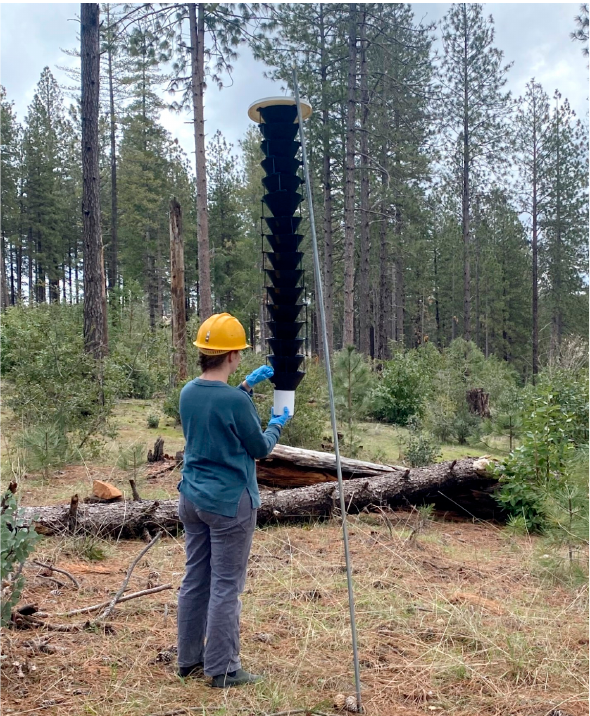
Figure 3. A multiple-funnel trap baited with exo -brevicomin, frontalin, and myrcene to collect western pine beetles ( Dendroctonus brevicomis ) for experimental purposes, California. Photo credit: L.A. Mortenson, USDA Forest Service.